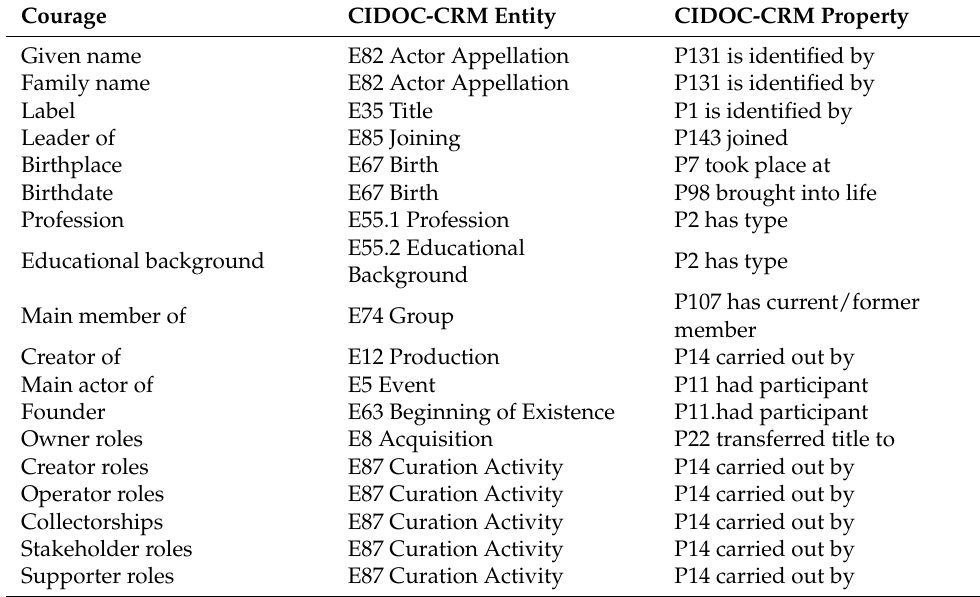
Table 1. COURAGE person entity representation in